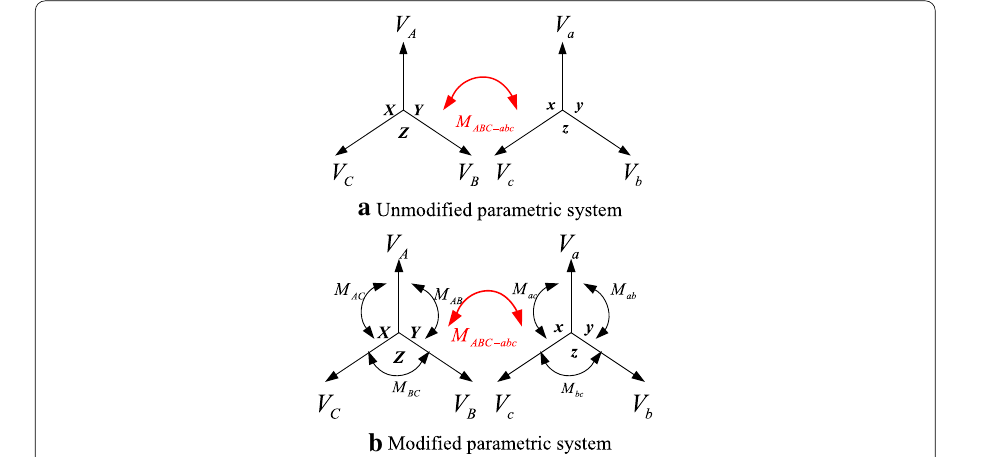
Fig. 11 Vector relations in parametric systems; Unmodified parametric system is used to describe vector relations by sequence-coordinates, which only the coupling relationship among windings is considered in ( a ).While Modified parametric system is used to describe vector relations by phase-coordinates, which coupling relationship among windings is considered containing the tree-phase coupling relations in ( b